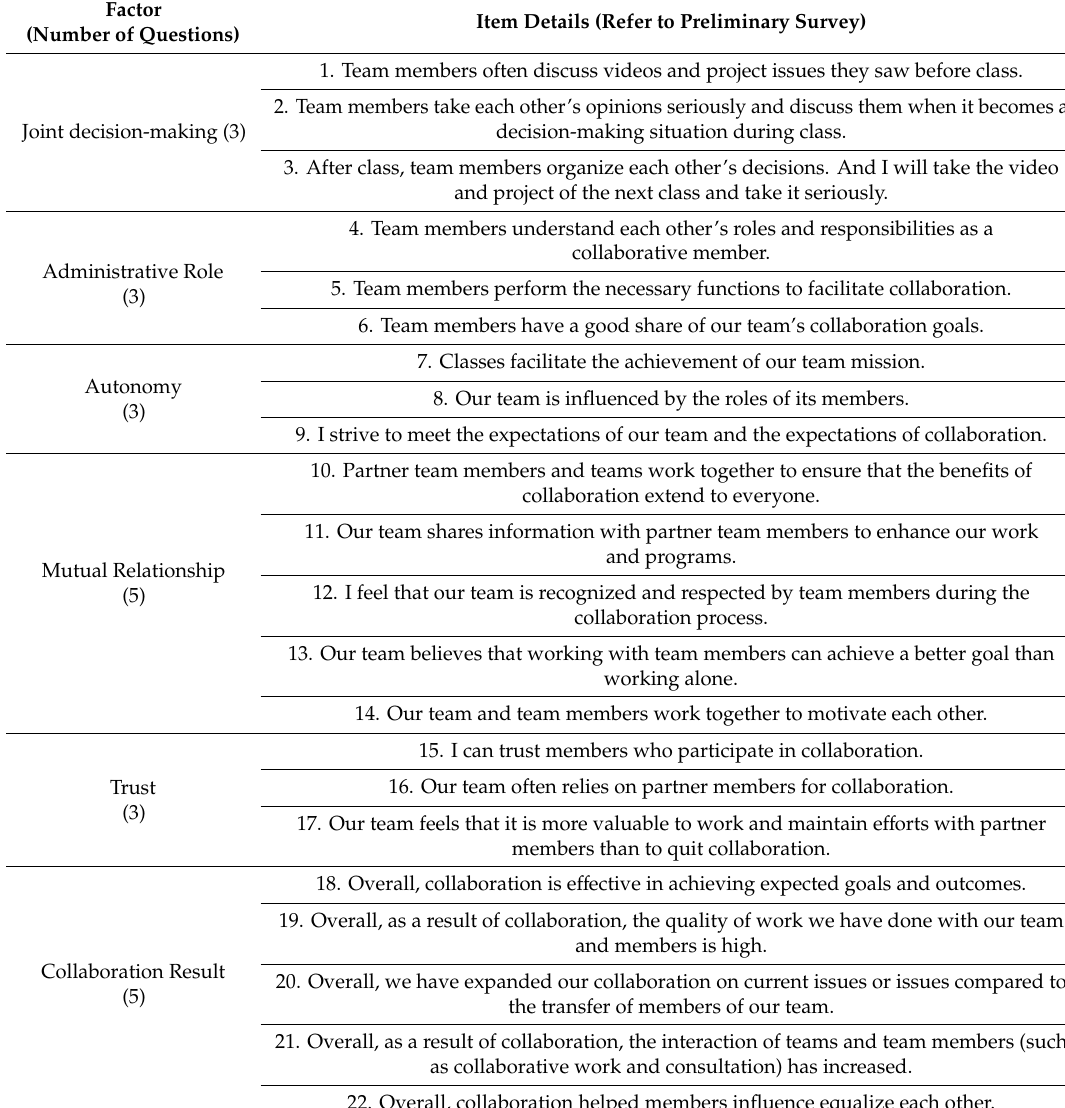
Table 10. Training satisfaction questionnaire for the level of